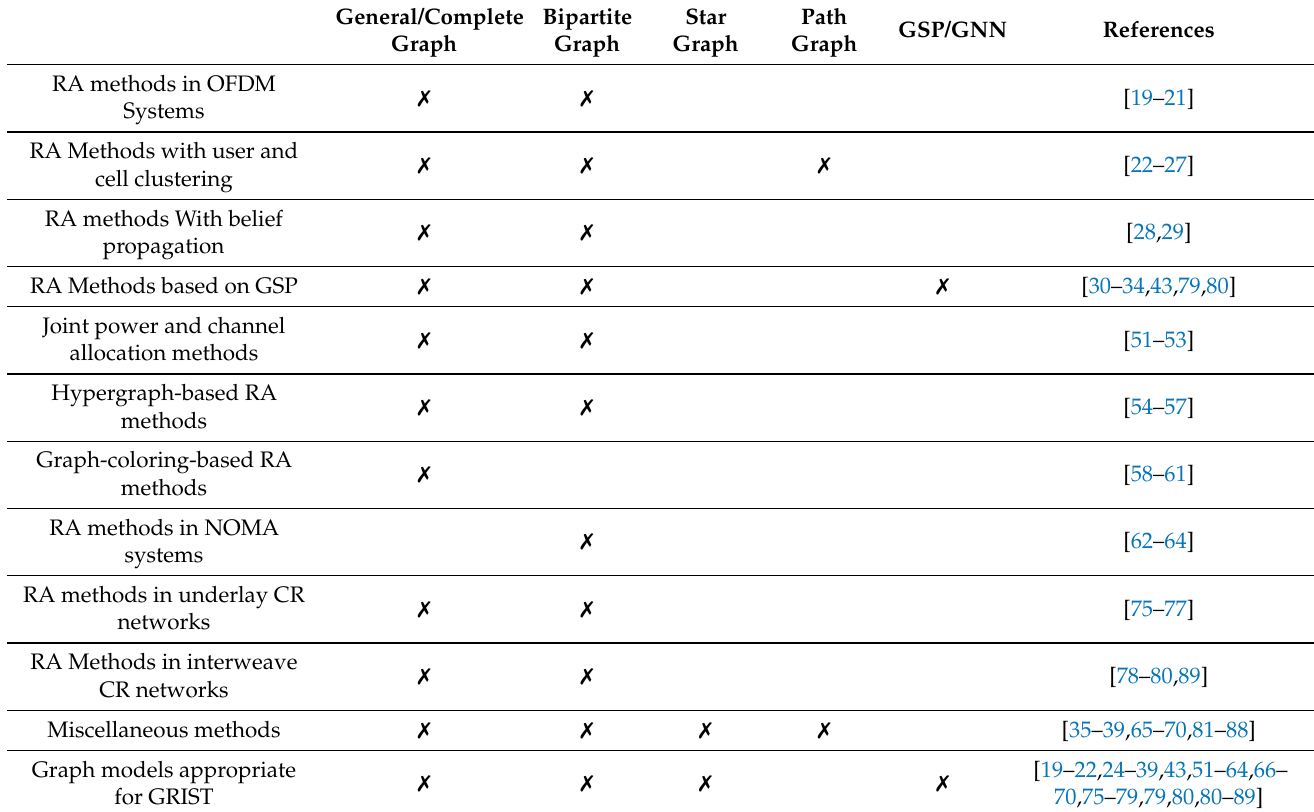
Table 9. Types of graphs in RA